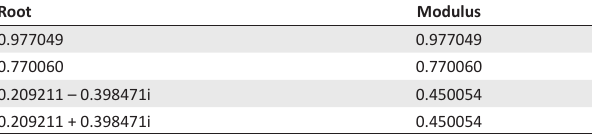
TABLE 5: Roots of characteristic polynomial.